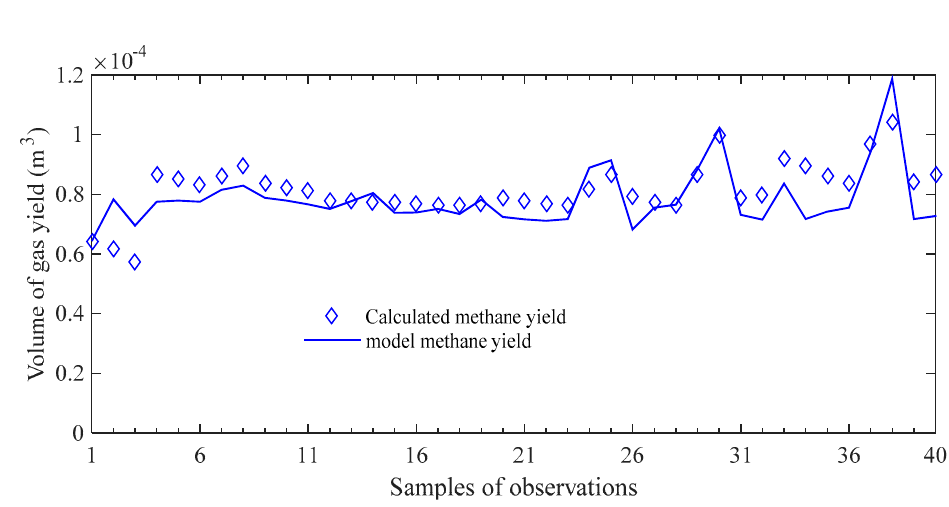
Figure 5. Validation of derived model using test calculated dataset.